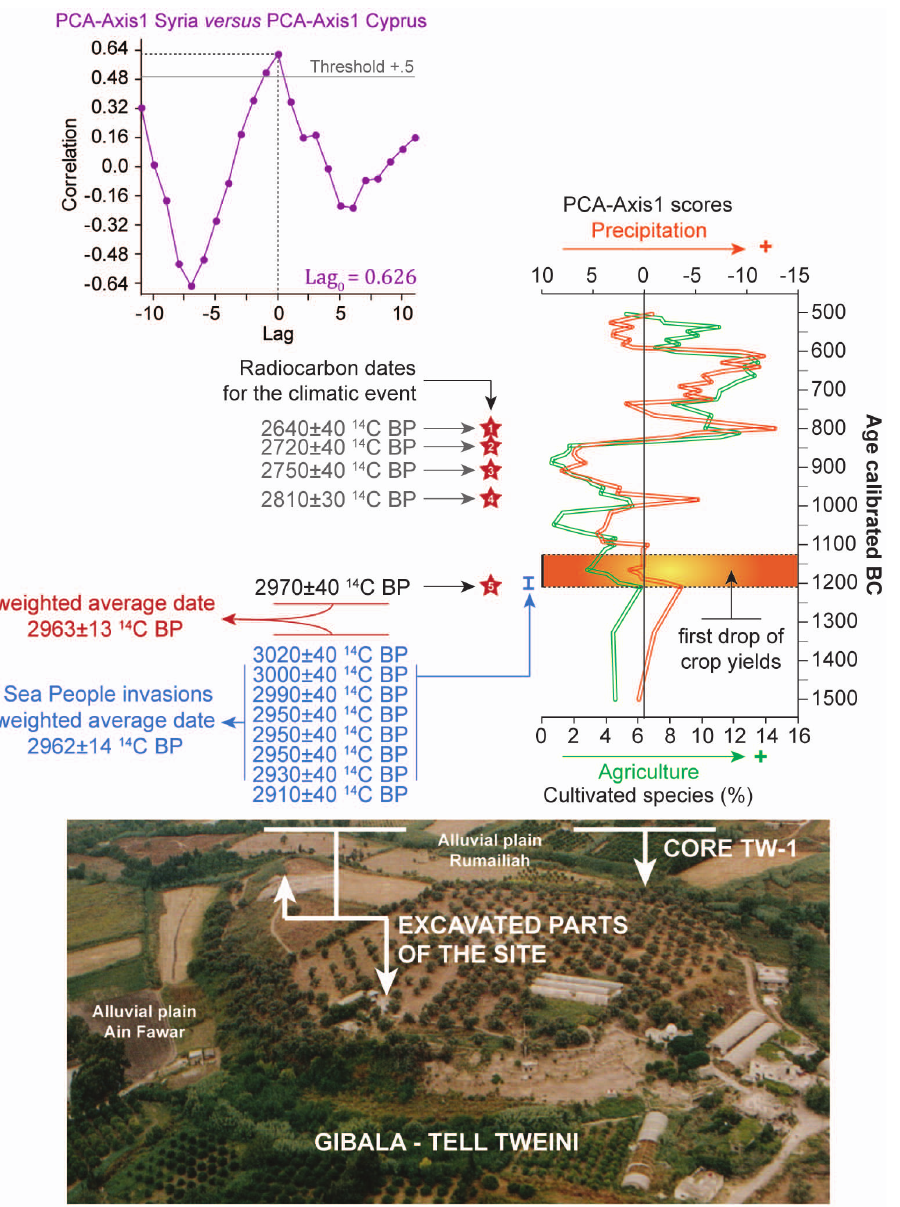
Figure 6. Radiocarbon-based archaeology, climate and agricultural productivity from Gibala-Tell Tweini, Northwest Syria. The pollen- derived climatic and agricultural proxies are plotted against time (1500–500 cal. BC). Radiocarbon dates for the ca. 300 year dry event are indicated with red stars. The time-window of the invasions at the Bronze-Iron Age boundary is framed by radiocarbon dates from the destruction layer (blue). At the top, the cross-correlogram shows the correlation between the pollen-derived proxy of moisture availability from Hala Sultan Tekke and that from Gibala-Tell Tweini. Vertical axes show correlation coefficients while horizontal axes show the lag (1 unit=1 sample). Significance level P=0.05 . doi:10.1371/journal.pone.0071004.g006 PLOS ONE |